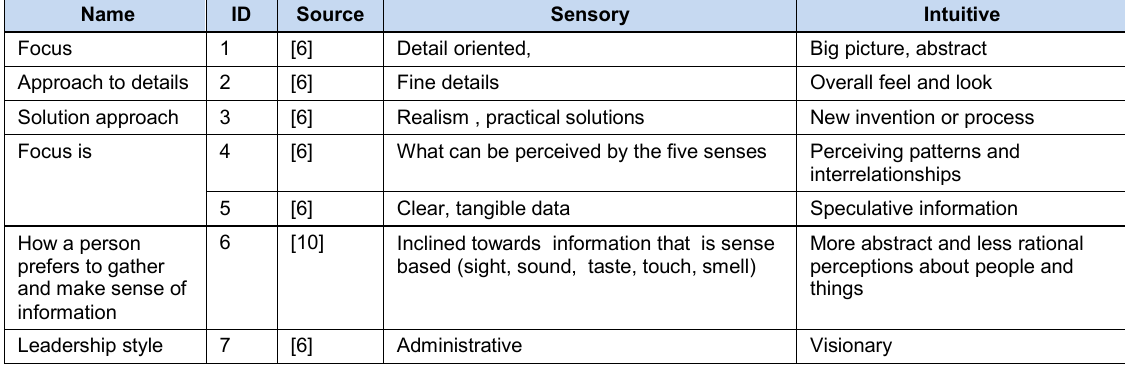
Table 2. Dimension